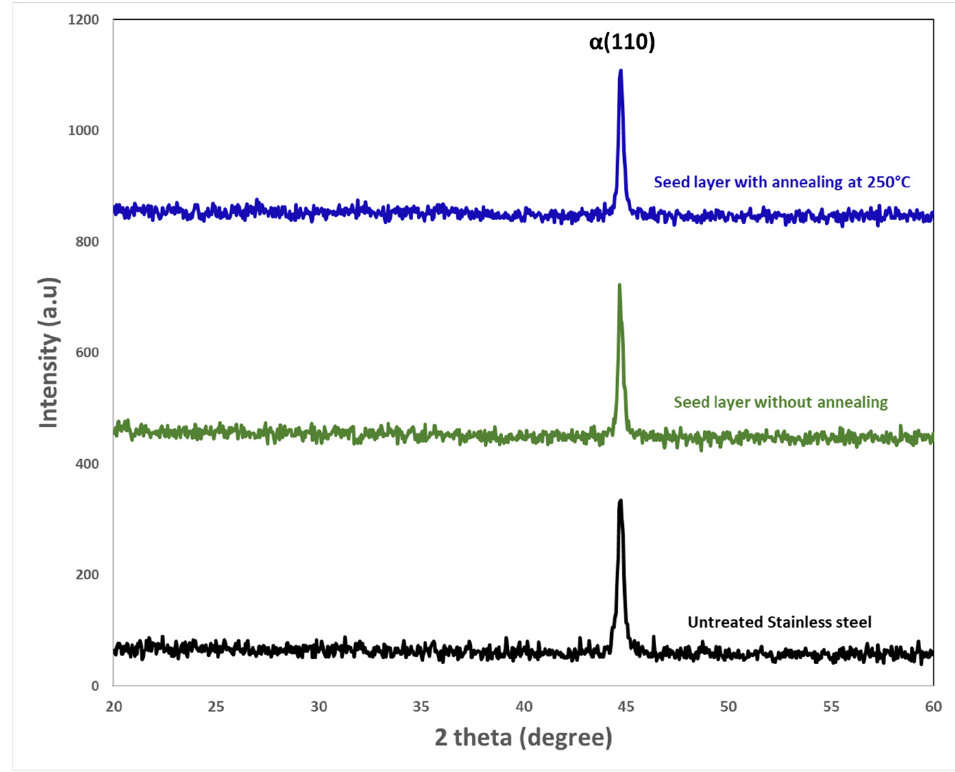
Figure 5. X-ray diffraction (XRD) patterns of untreated stainless steel, ZnO Seeds deposited on stainless steel with and without annealing at 250 °C.